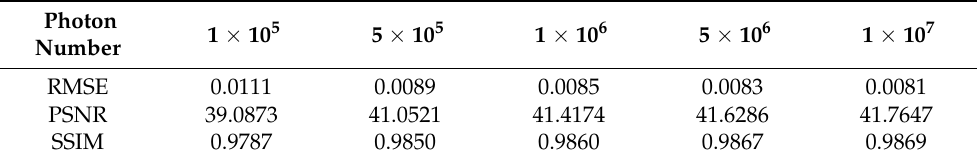
Figure 10. Reconstructed results (from 32 views) and absolute residuals at different noise levels. ( a ) The reference image, ( b ) our network result with I 0 = 1 × 10 7 , ( c ) the result with I 0 = 5 × 10 6 , ( d ) the result with I 0 = 1 × 10 6 , ( e ) the result with I 0 = 5 × 10 5 , and ( f ) the result with I 0 = 1 × 10 5 . The display window is [ − 150, 250] HUs in size. ( g ) The residual error between (b,a), ( h ) the residual error between (c,a), ( i ) the residual error between (d,a), ( j ) the residual error between (e,a), and ( k ) the residual error between (f,a). The display window is [ − 0.2, 0.2]. Table 3. Robustness analysis results for different noise levels.